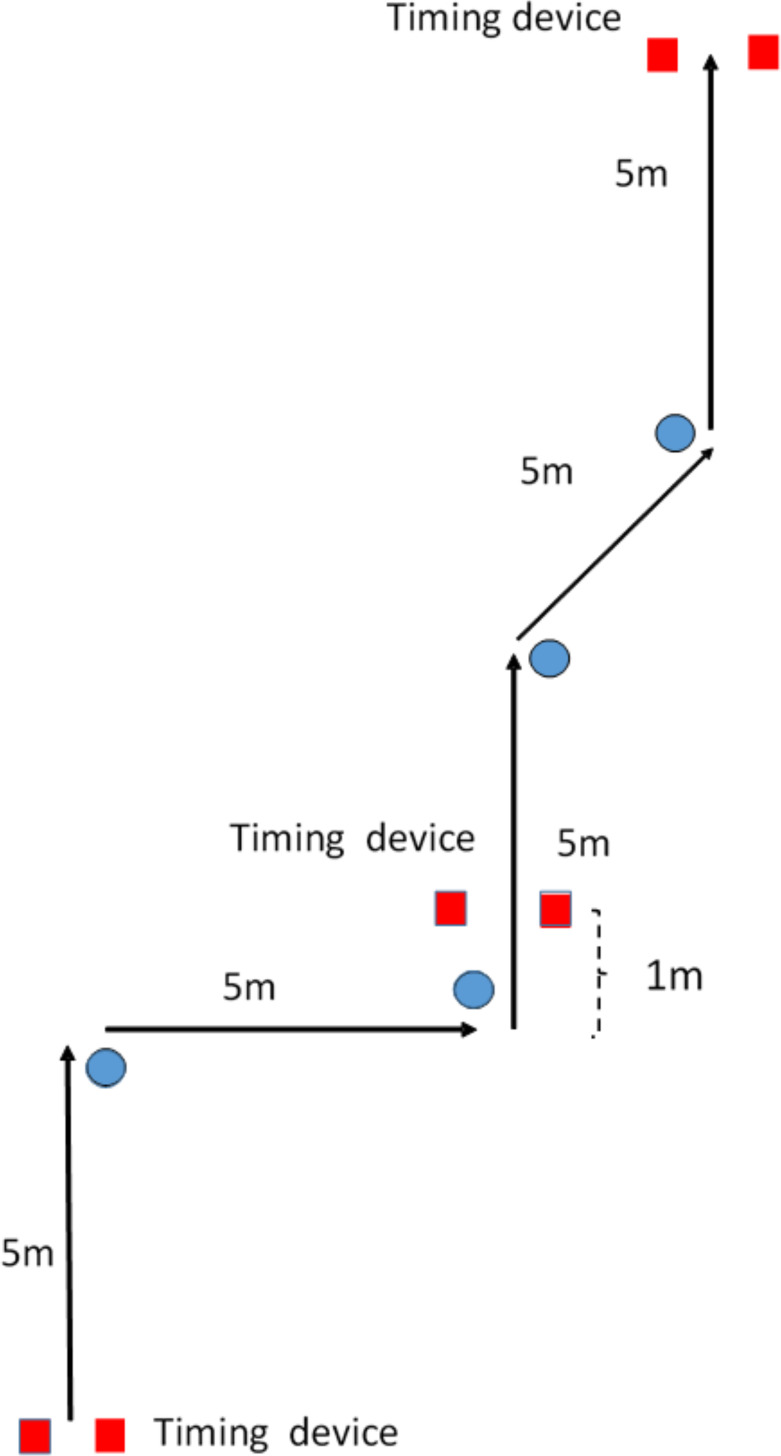
Change of Direction (COD) test with two 90° followed by two 45° turns with timing after the two 90° and 45° turns.